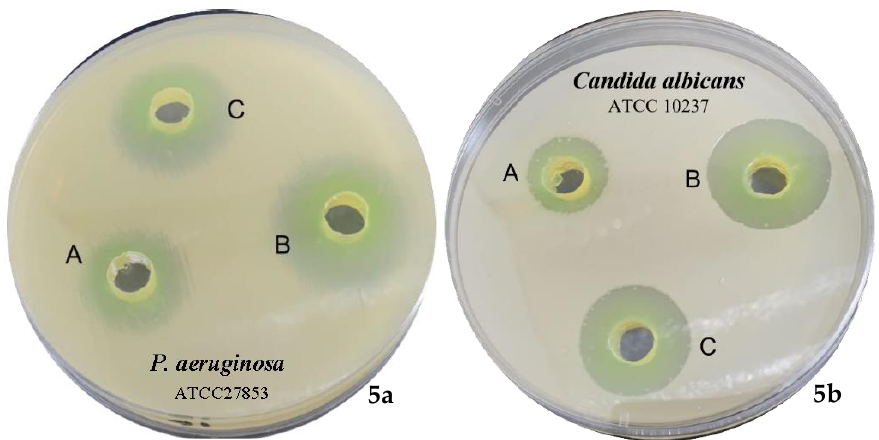
Figure 5. Antibacterial activity of CuNPs against P. aeruginosa ATCC 27853 ( 5a ) and C. albicans ATCC 10237 ( 5b ). (A) Tamarixinin A, (B) Formulated CuNPs using tamarixinin A, and (C) Streptomycin, and Fluconazole (10 mg/mL) positive controls.